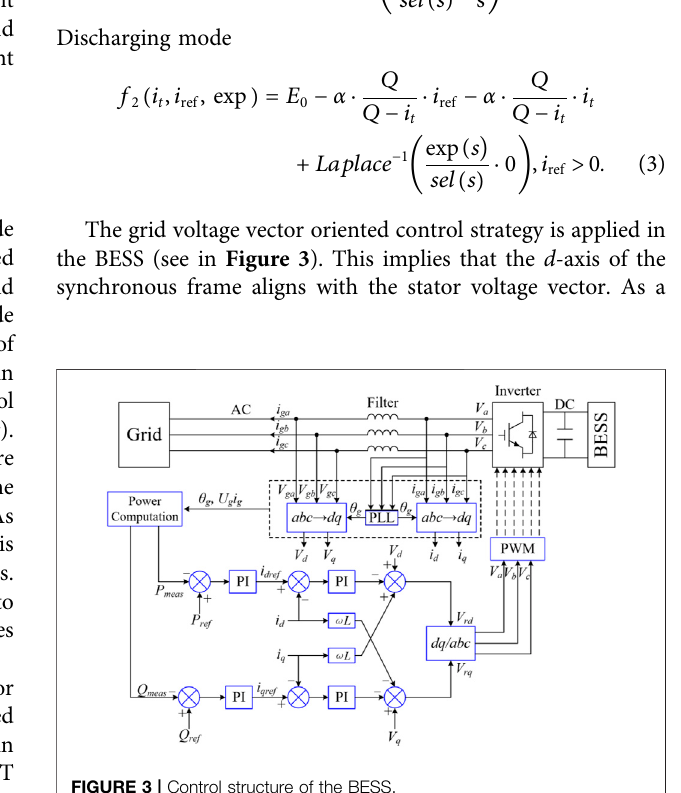
FIGURE 3 | Control structure of the